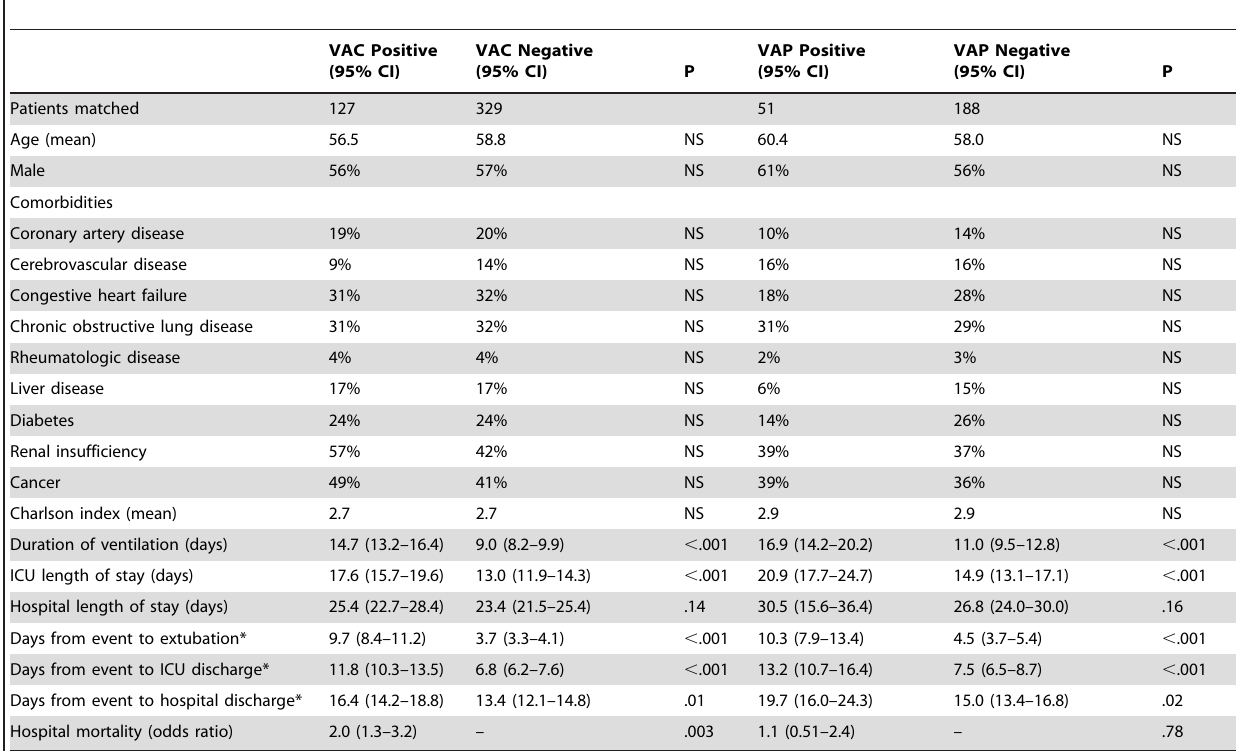
Table 3. Results of linear and logistic regression models comparing patient outcomes for ventilator-associated complication or ventilator-associated pneumonia relative to matched patients without ventilator-associated complications or ventilator-associated pneumonia